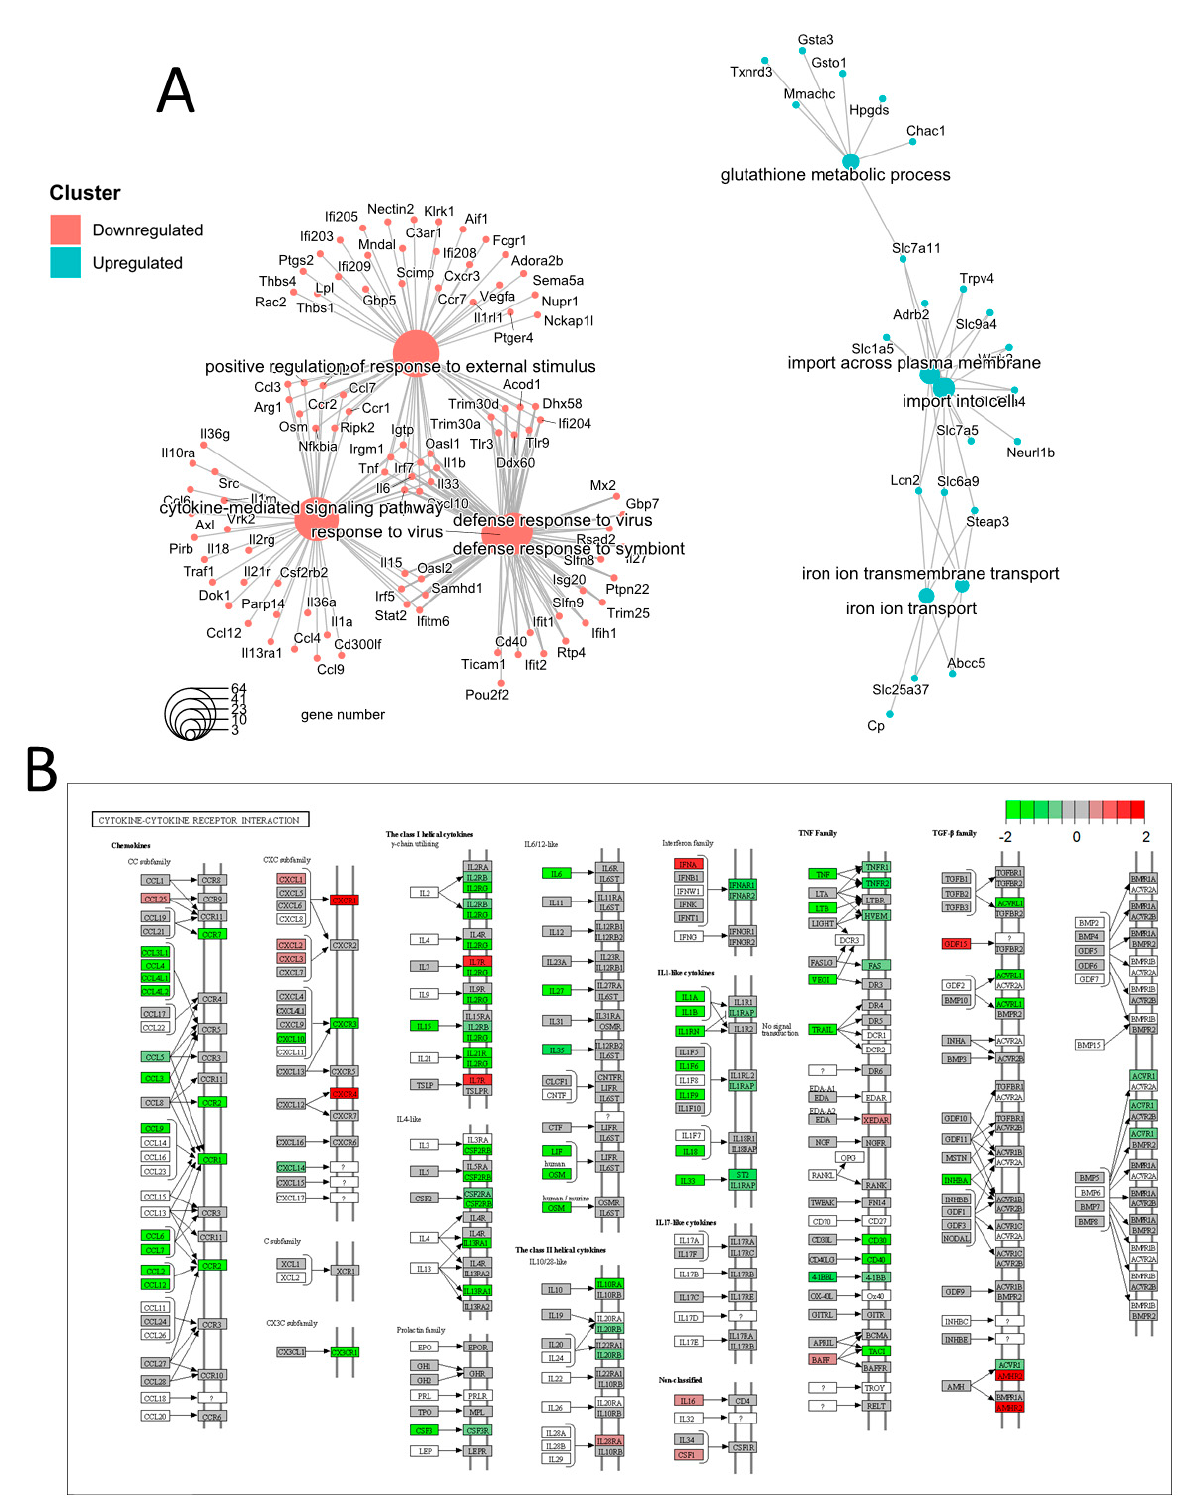
Figure 3. Transcriptomics showed an intense downregulation of cytokine production and regulation processes. ( A ) Category net plot of GO terms enriched for over − and underexpressed genes separately. ( B ) Cytokine–cytokine receptor interaction pathway showing integrated transcriptomics data. Genes overexpressed (in red) or underexpressed (green) according to the transcriptomic analysis are highlighted.